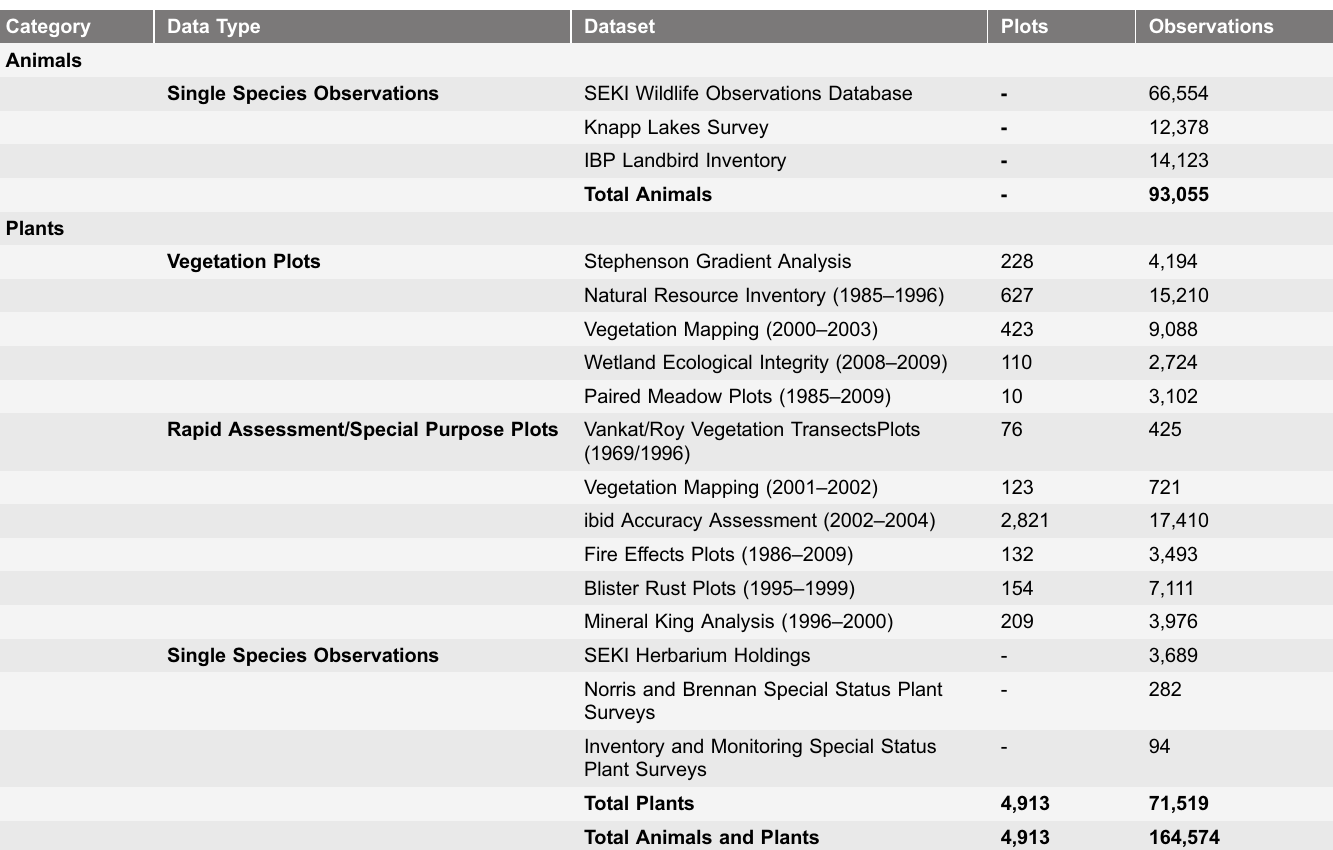
Table 1. Data sets and sample sizes used to estimate species richness values for birds, mammals, amphibians, reptiles and plants of Sequoia and Kings Canyon National